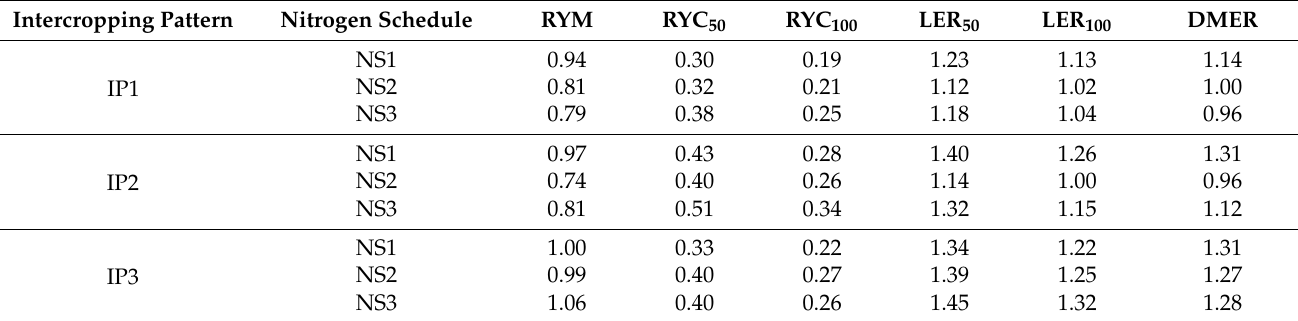
Table 9. Relative yields of the main maize crop (RYM) and the companion forage cowpea crop based on 50 and 100% pure cowpea stands (RYC 50 and RYC 100 ), land equivalent ratio (LER), and dry matter equivalent ratio (DMER) for the evaluated intercropping pattern and nitrogen